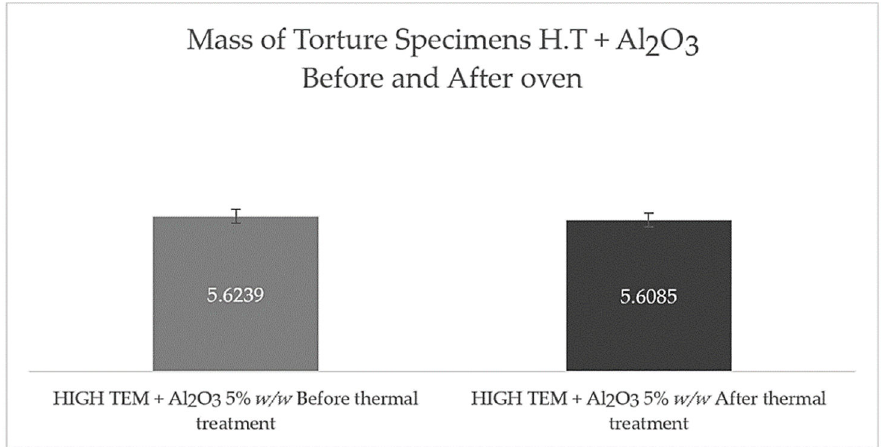
Figure 9. Weight loss assessment of the formulated hybrid ceramic resin, before and after thermal treatment.